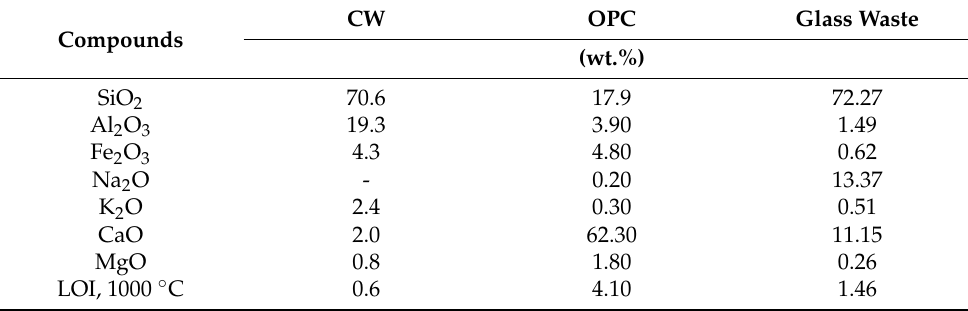
Table 2. Chemical composition for raw materials.